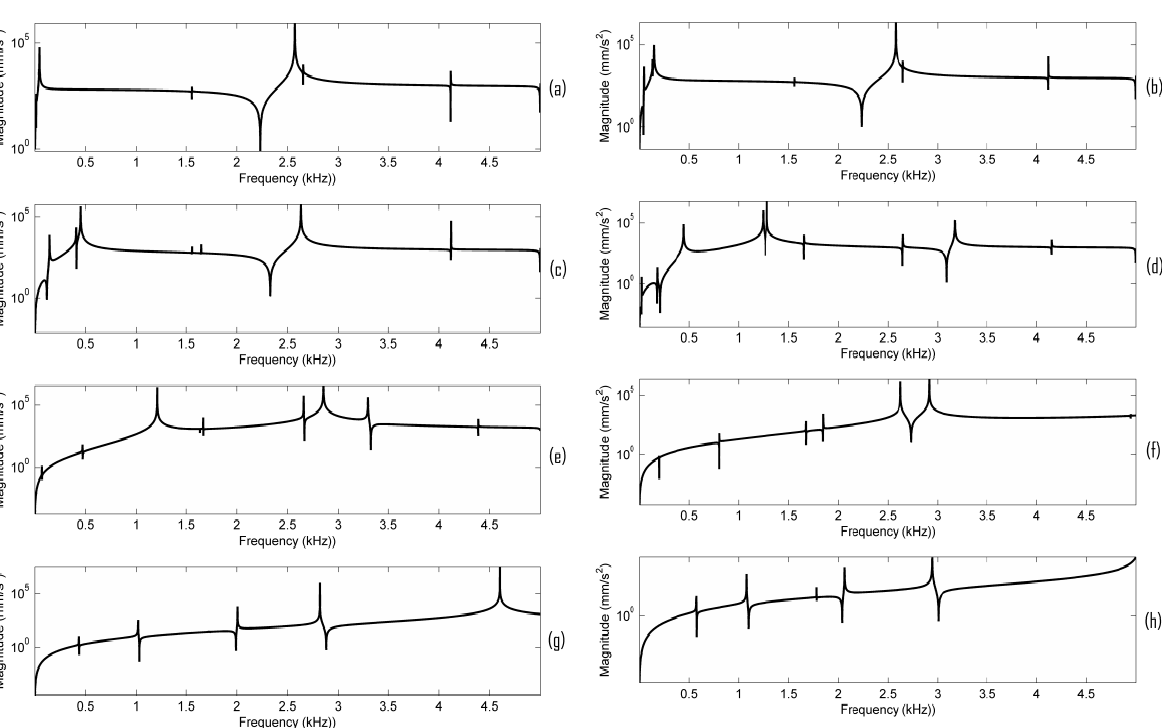
Figure 6. Frequency responses of the bridge in Figure 1a under different contact stiffness with the damping ratio 0.017% critical. EPS1 was set as ( a ) 0.001; ( b ) 0.01; ( c ) 0.1; ( d )